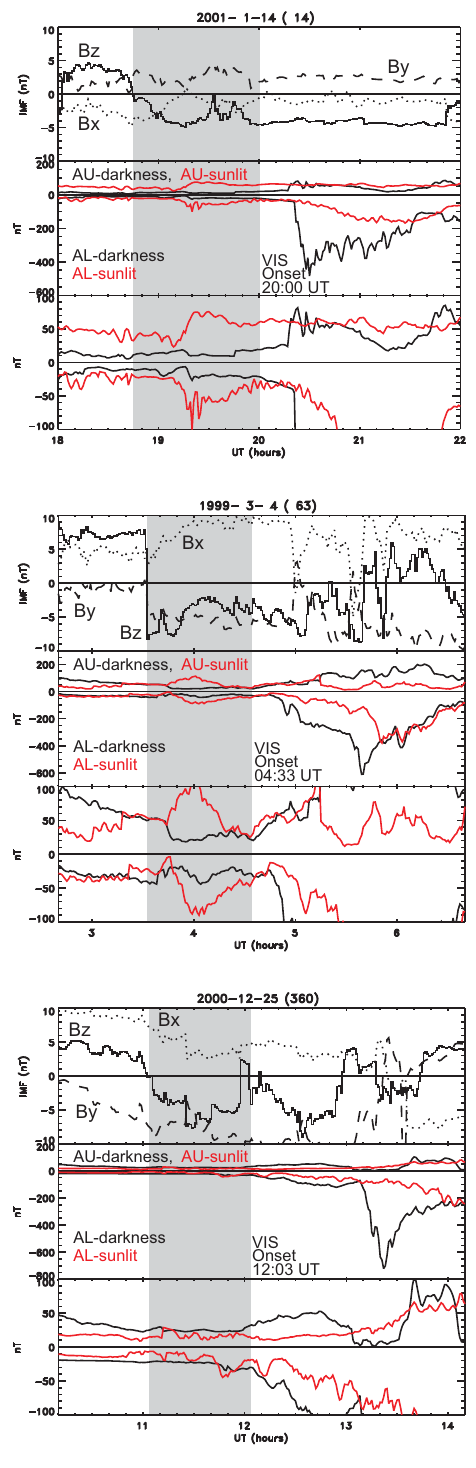
Fig. 10. Three examples of events that develop into strong sub- storms. Top panel shows the IMF, the second and third panels both show the AU/AL but in the third panel the y-axis is expanded to focus on any subtle pre-onset signature. The grey bar indicates the period between the southward turning and the onset of any abrupt auroral